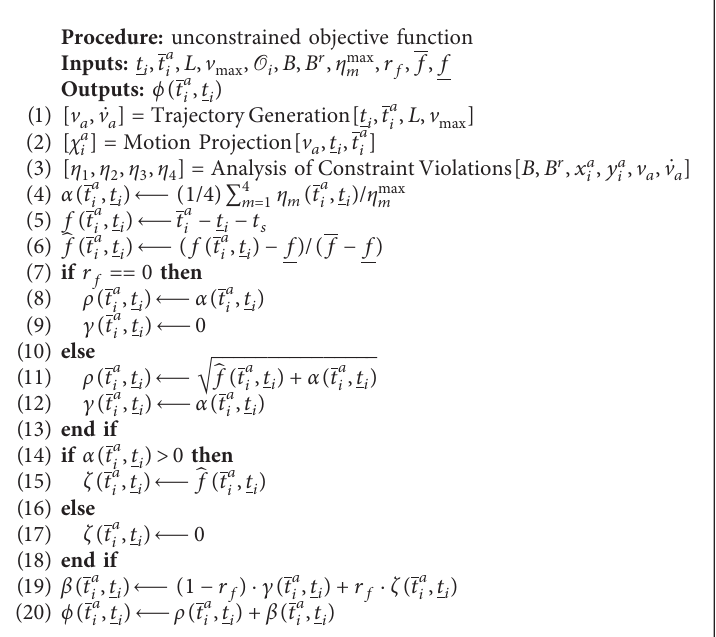
A LGORITHM 2: Pseudocode of the unconstrained objective function procedure. The procedure computes the fitness value of the objective function that corresponds to a candidate solution of the unconstrained optimization